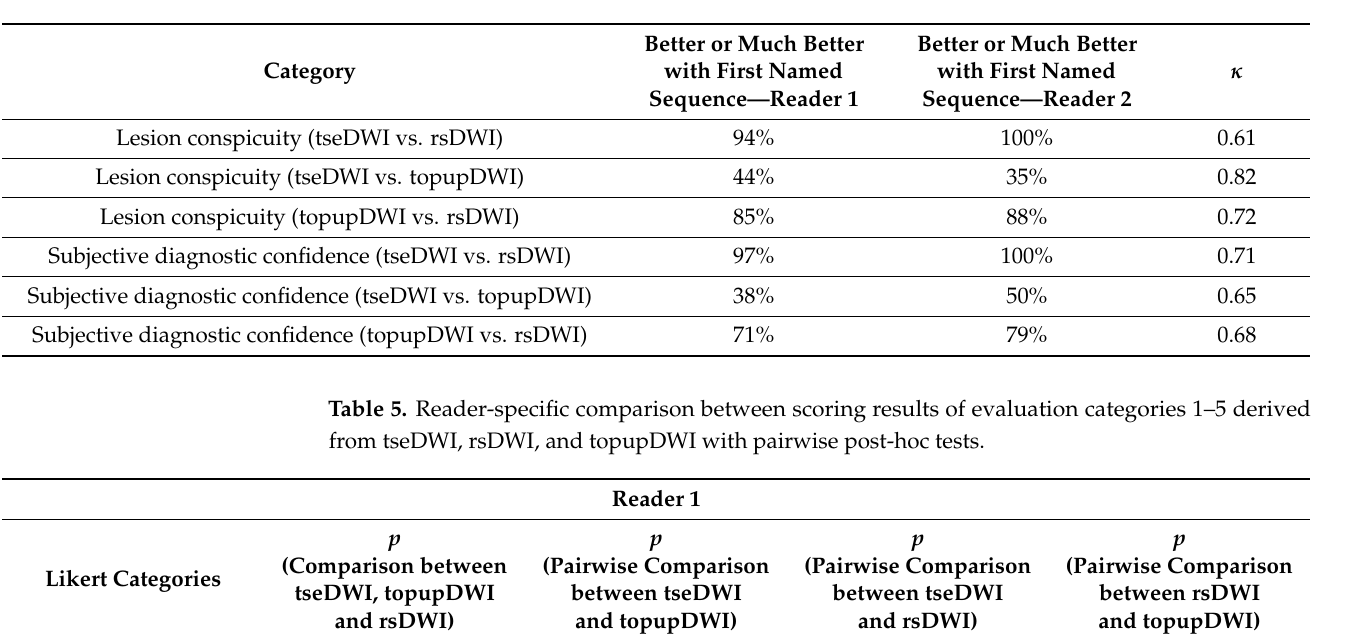
Table 4. Likert scoring results for evaluation of categories 7–12 per reader and inter-rater agreement ( κ values). Each listed percentage value refers to a better or much better rating of the first named DWI sequence in brackets (e.g., tseDWI vs. rsDWI).